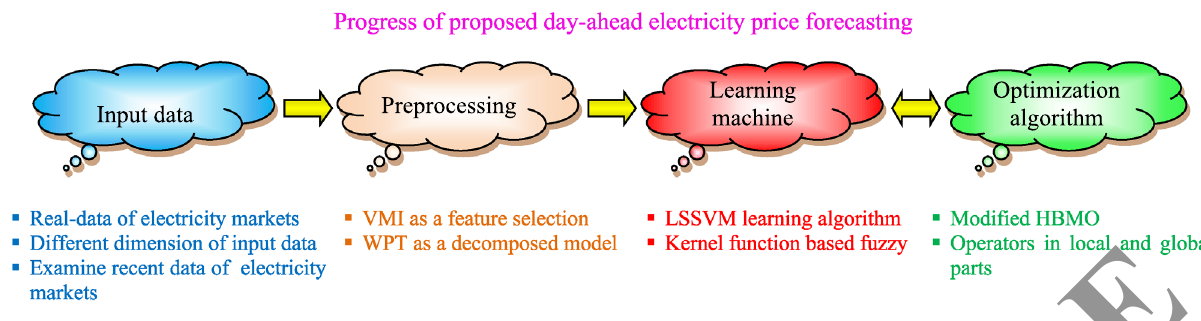
Figure 4. Outline of the main contributions for this paper in day-ahead electricity price forecasting.